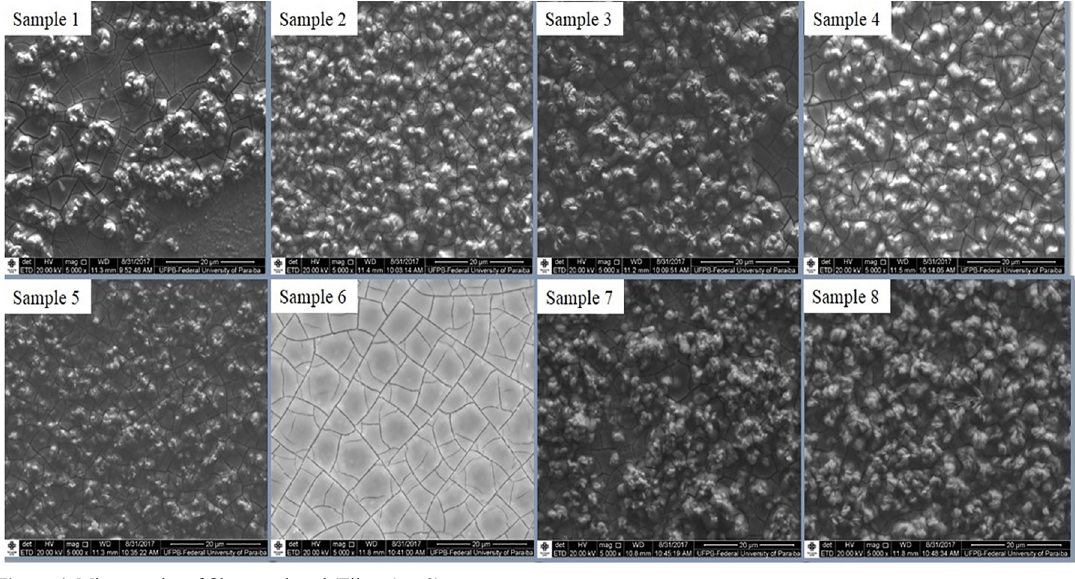
Figure 4. Micrography of films produced (Films 1 to 8).